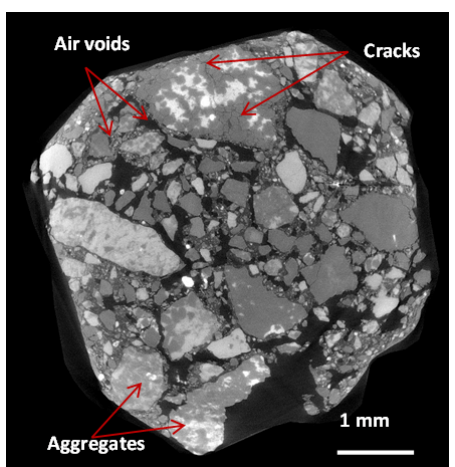
Figure 5. Micro CT image of cured CBEA